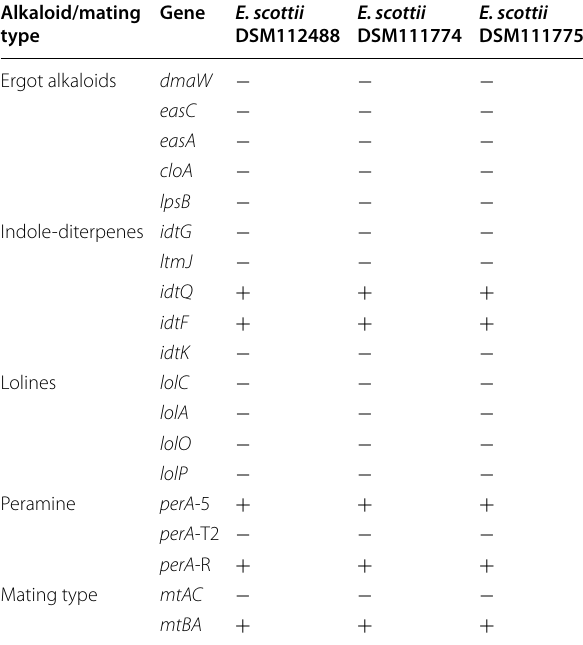
Genes for ergot alkaloid, indole-diterpene and loline biosynthesis are displayed in order of their involvement in the corresponding biosynthesis pathway. For peramine, which is encoded by a single gene, gene fragments are ordered from the 5 ′ to 3 ′ end of each gene part